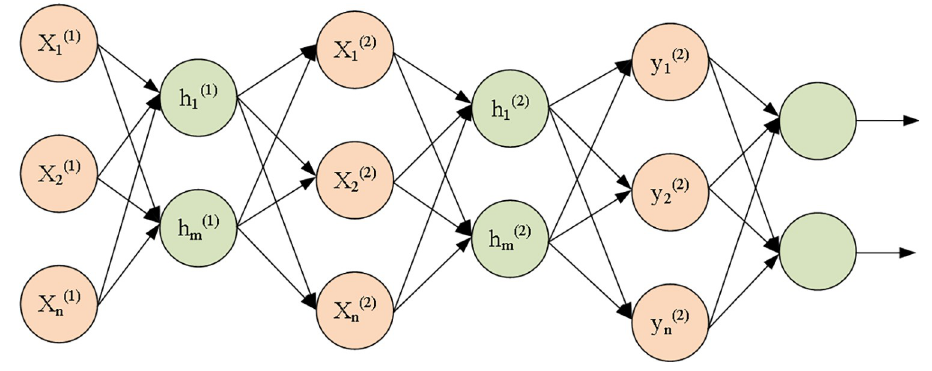
Fig 3. Network structure.